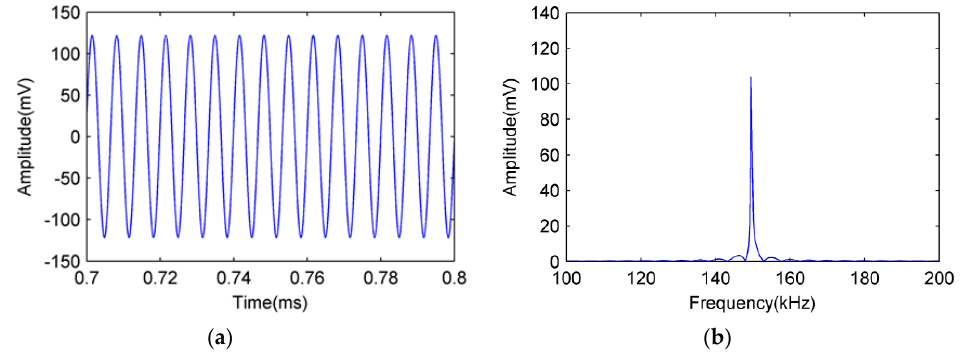
Figure 9. Sinusoidal signal detected by FOR AE sensor. ( a ) Time domain diagram; ( b ) Frequency domain diagram.